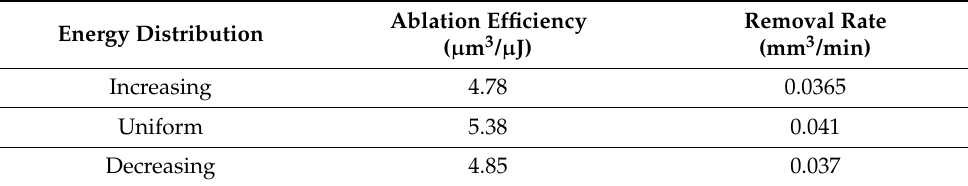
Table A8. Ablation efficiencies and removal rates of